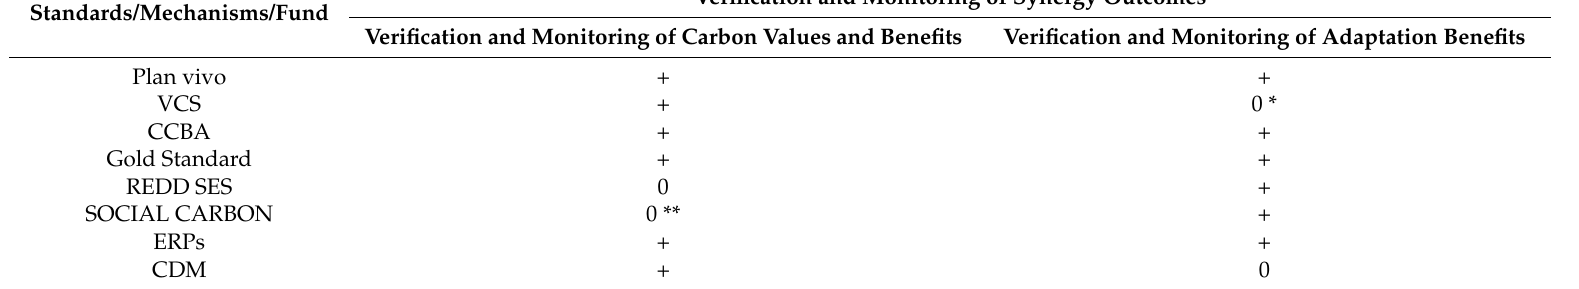
Table 4. Monitoring and verifying synergy